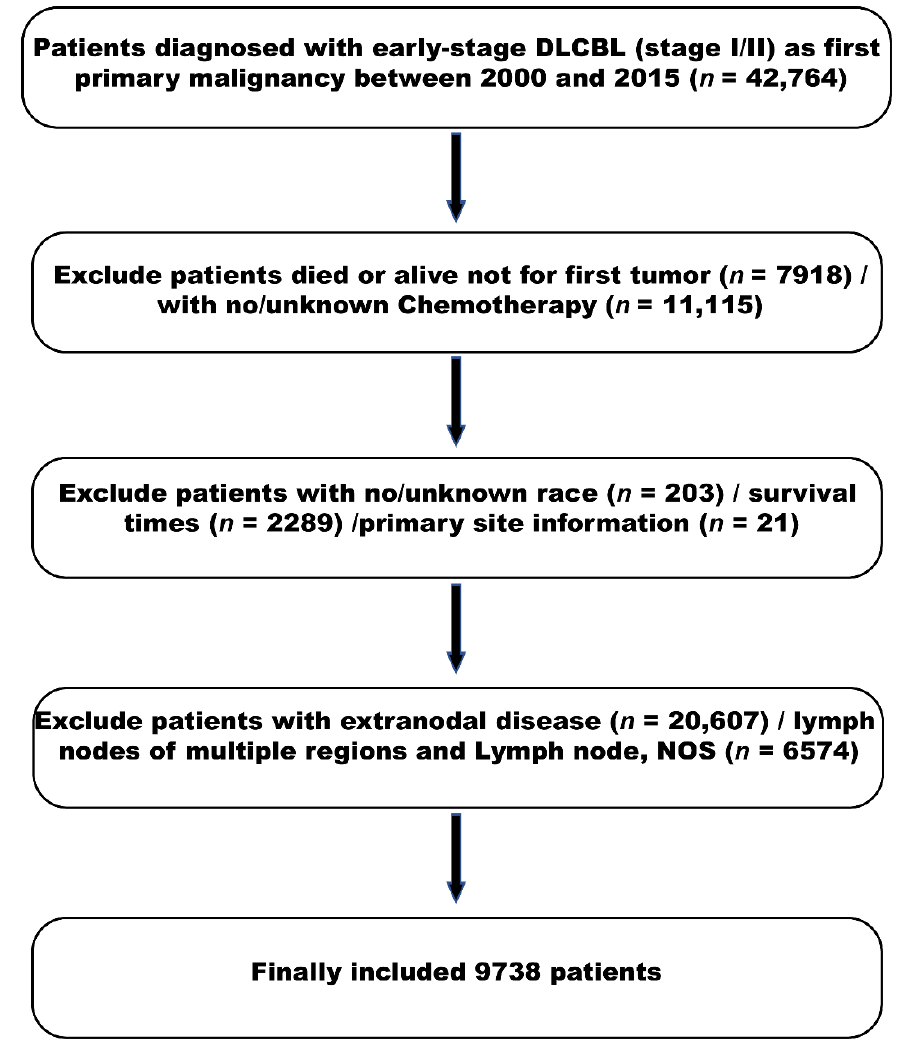
Figure 1. Flow chart of patient selection from the Surveillance, Epidemiology, and End Results (SEER) database.